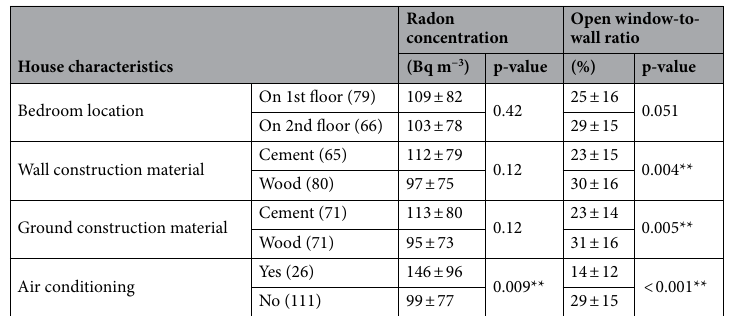
Table 3. Arithmetic means indoor radon concentrations and open window-to-wall ratios depending on location, house construction materials, and air conditioner use.